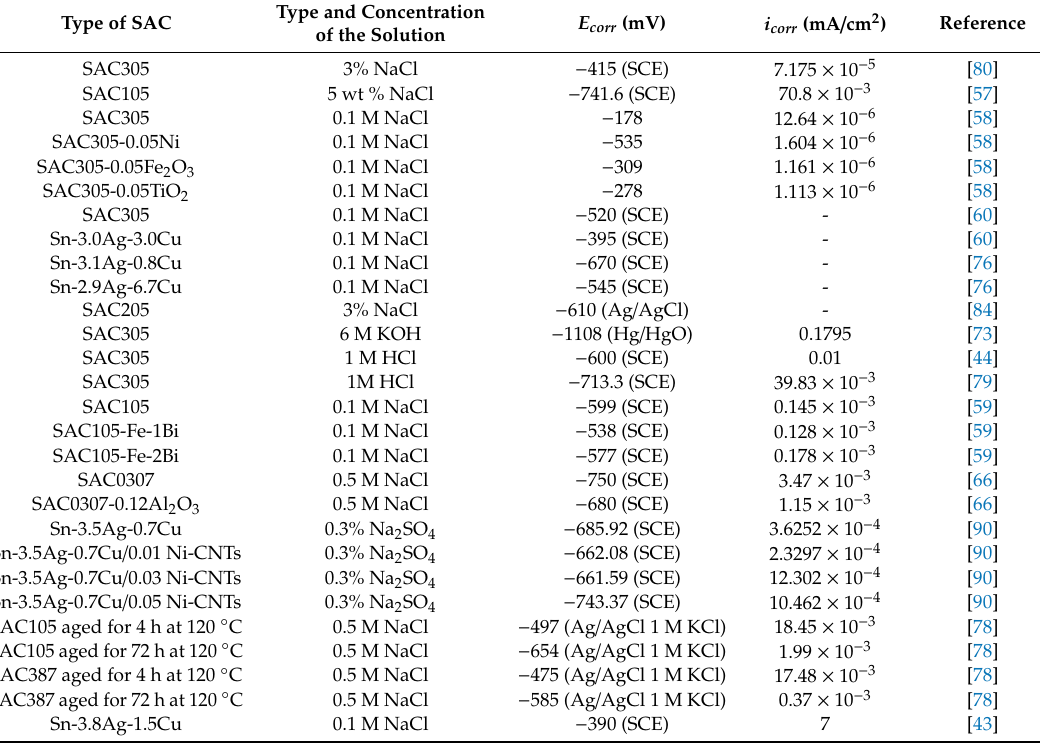
Table 3. Experimental data of SAC alloys after LSV in other